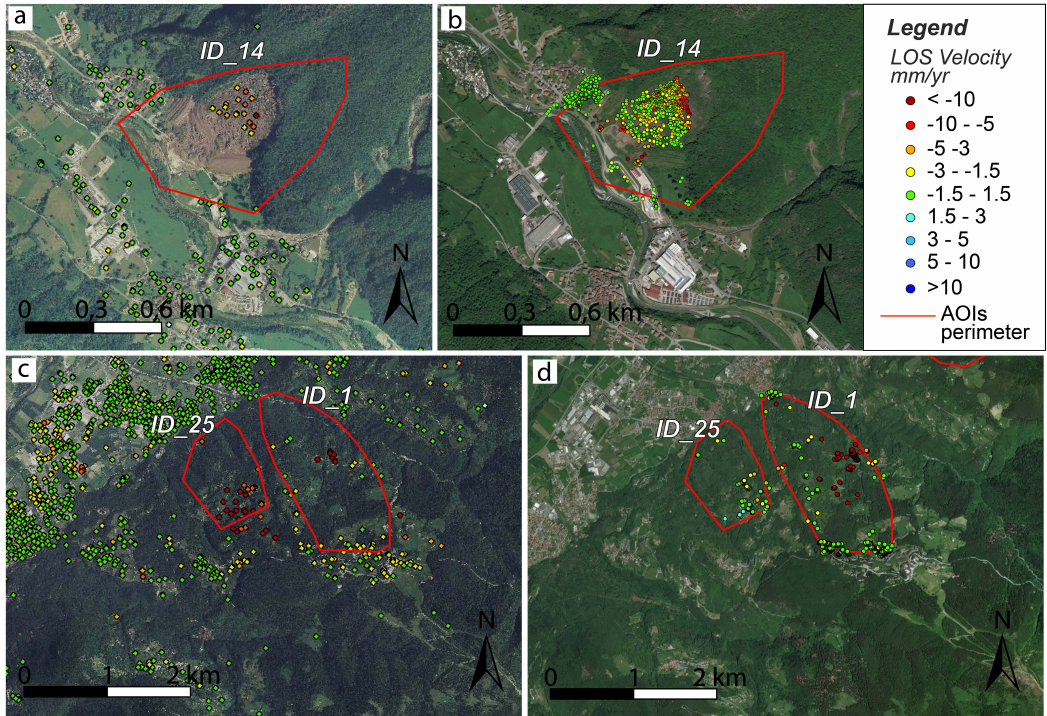
Figure 10. Examples of A-DInSAR results for Envisat and COSMO-SkyMed datasets; ( a , b ) Envisat descending and COSMO-SkyMed descending respectively, for the AOI ID_14; ( c , d ) Envisat descending and COSMO-SkyMed ascending respectively, for the AOIs ID_1 and ID_25. The PS mean velocity values are measured along the satellite LOS. The Envisat data are form the Italian Ministry of the Environment and for Protection of the Land and Sea